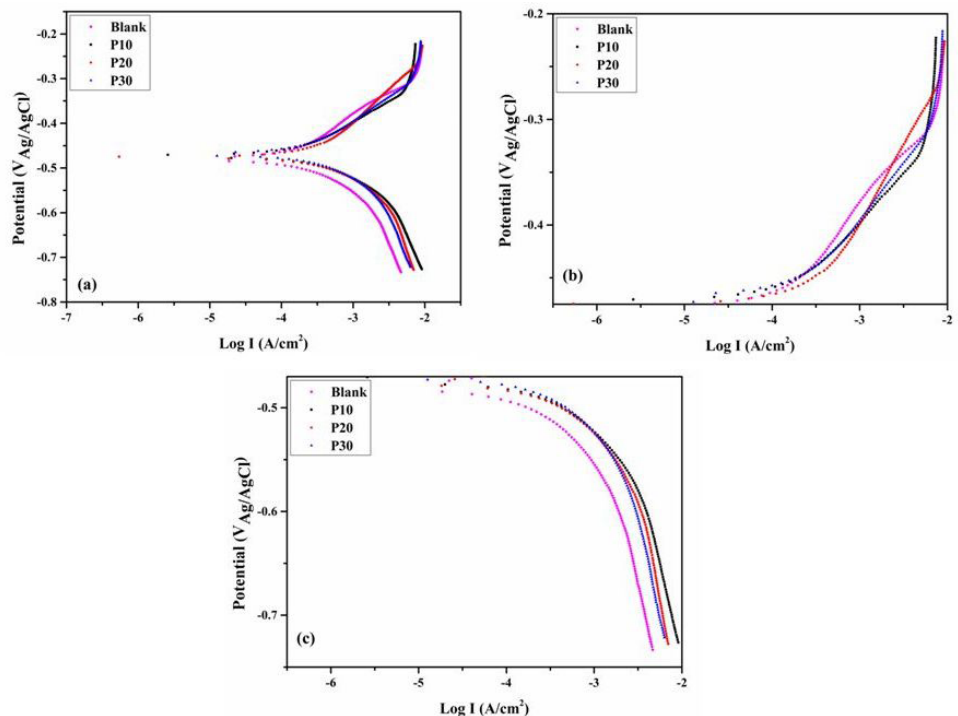
Figure 10. Potentiodynamic polarization curves for immersed API P110 carbon steel coupons in the absence and presence of P10, P20 and P30 at 303 K (a); anodic branches (b) and cathodic branches